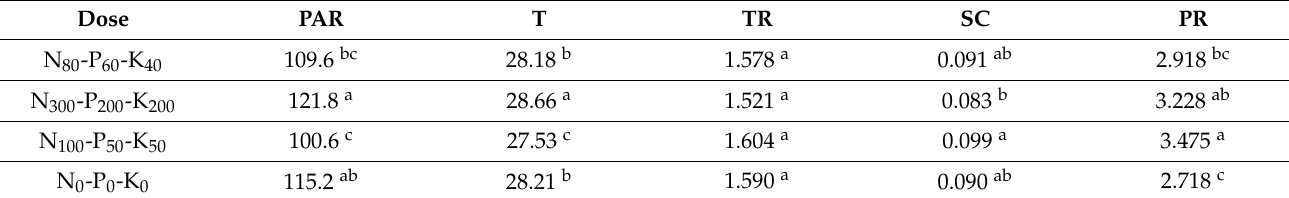
Table 5. Photosynthetically active radiation (PAR, µ mol m − 2 s − 1 ), leaf chamber temperature